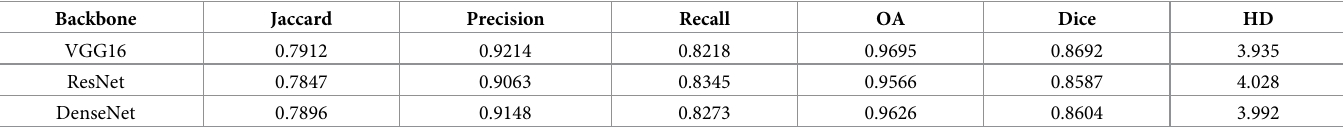
Table 2. Comparison of results of different backbone networks.